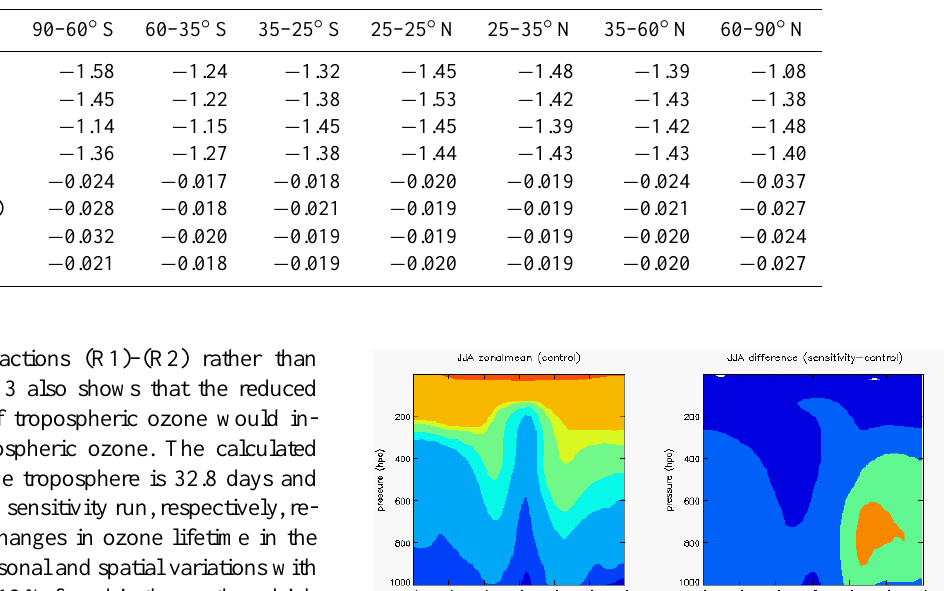
∗ DJF: December–February for Northern Hemisphere winter; MAM: March–May for Northern Hemisphere spring; JJA: June–August for Northern Hemisphere summer; SON: September–November for Northern Hemisphere fall. Table 2. Sensitivity factors of average surface J (O 3 ) and J (NO 2 ) .